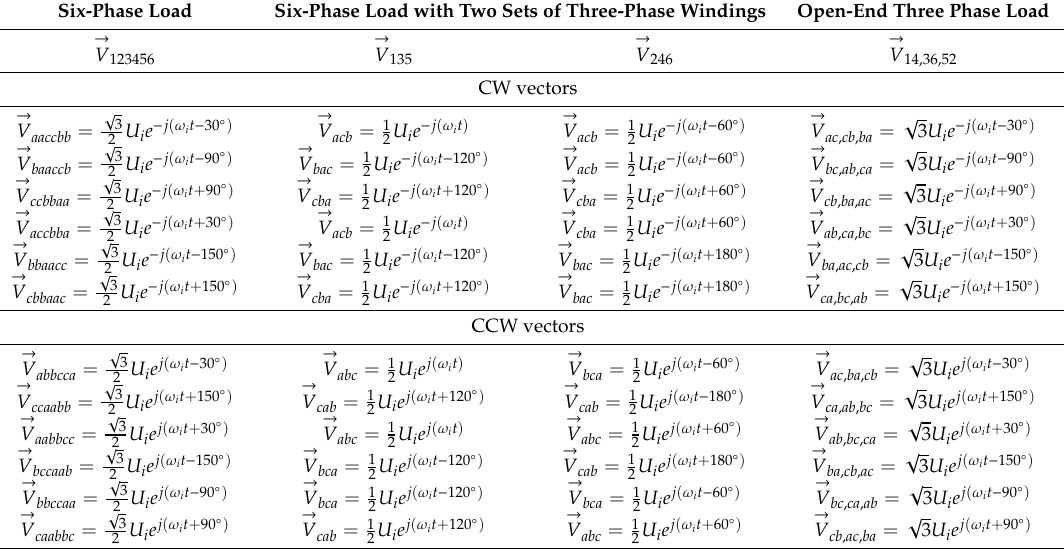
Table 1. The names and relations defining the rotating voltage space vectors resulting in elimination of the CMV.